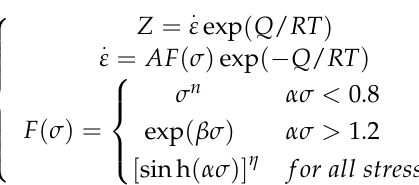
Figure 5. The flow behavior of a Ti-6Al-4V alloy at ε = 0.2 during the air cooling process after superplastic deformation: ( a ) true stress; ( b ) strain-rate sensitivity parameter.